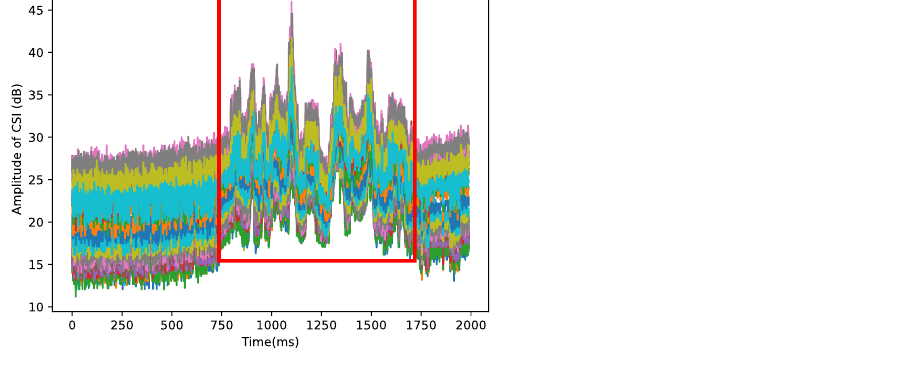
Figure 3. The amplitude of 30 subcarriers are drawn with different colors. These signal patterns, circled by a red box, correspond to the human behavior that causes